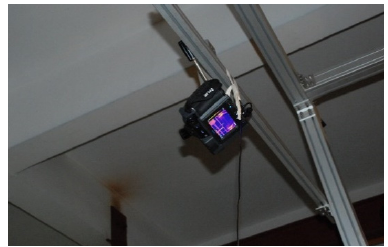
Figure 8. Infrared thermal imager.